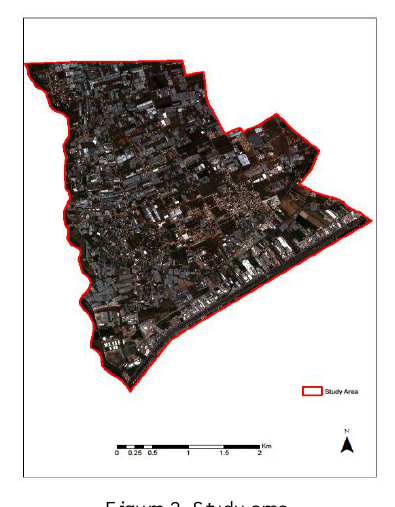
Figure 2. Study area.